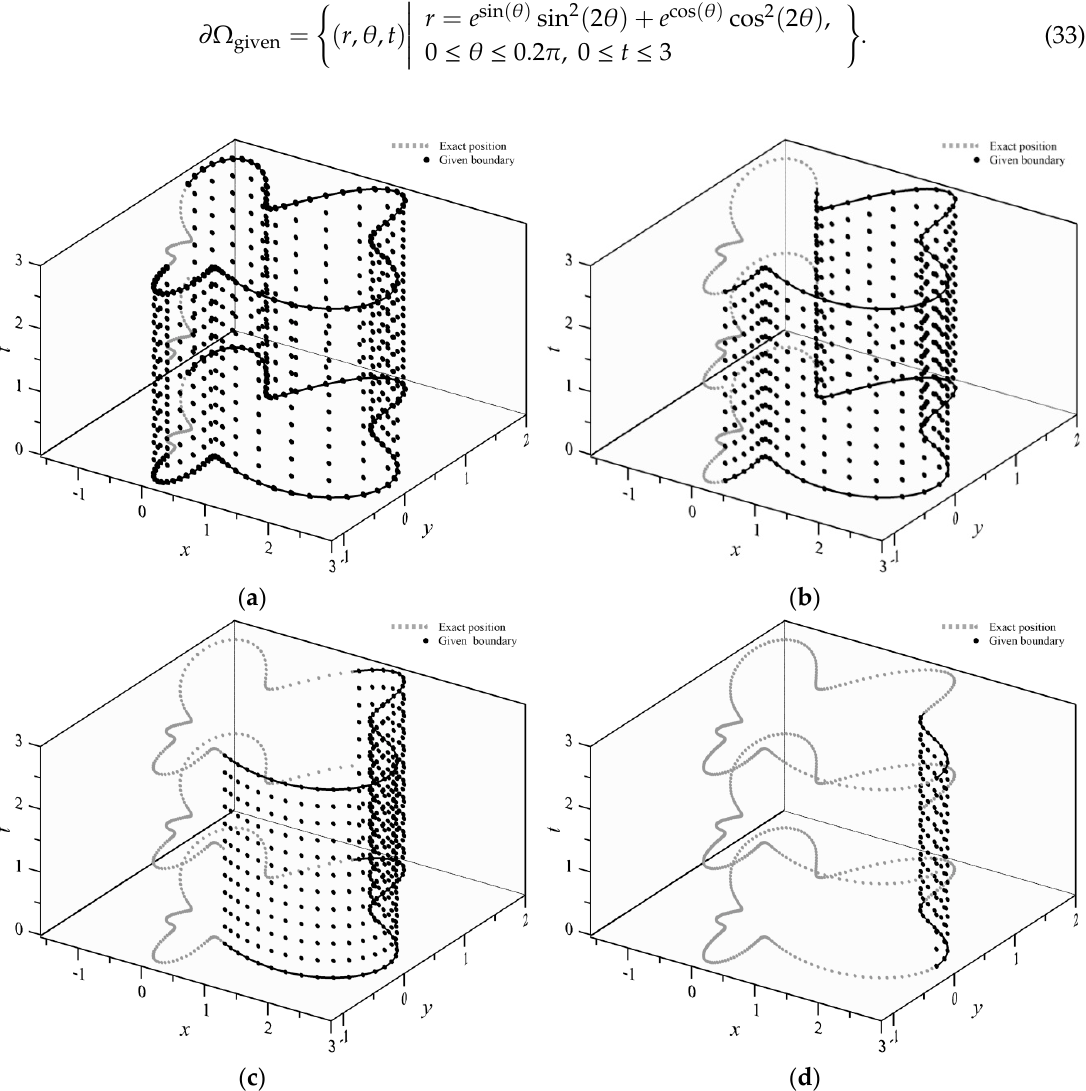
Figure 6. Four cases for missing space–time boundary conditions: ( a ) case A; ( b ) case B; ( c ) case C; ( d ) case D.